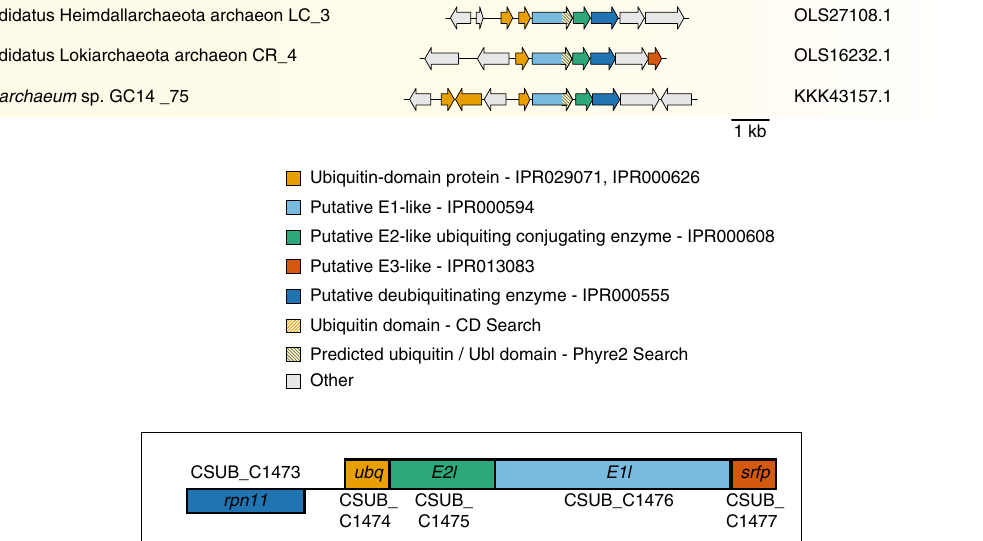
Fig. 1 Operonic arrangement of the putative archaeal ubiquitylation apparatus. a Gene clusters of the putative ubiquitin-like protein modi fi er system identi fi ed in archaeal species: the ubiquitin, E1-like, E2-like and small RING fi nger protein (srfp) components are coloured as indicated in the key. The Cluster I and II division is described in Supplementary Fig. 1, which provides a more comprehensive analysis showing an additional Cluster III. See Methods and Supplementary Table 2 for more details on the E1-like C-terminal ubiquitin-like (UBL) domain identi fi cation. (boxed inset): Operonic arrangement of the genes encoding the components of the C. subterraneum ubiquitylation cascade investigated in this study. The Rpn11/JAMM domain metalloprotease homologue is juxtaposed to the operon and transcribed right to left, whereas the ubiquitylation operon is transcribed left to